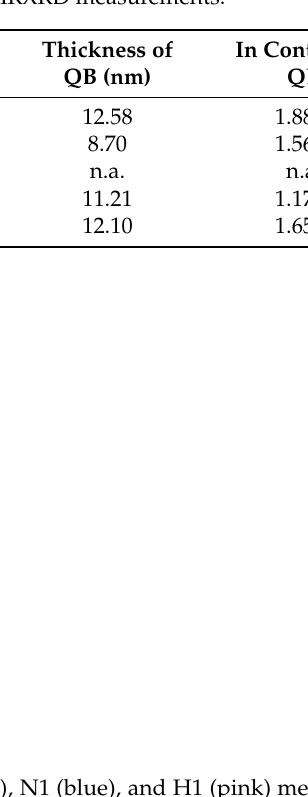
Figure 1. High-resolution X-ray diffraction (HRXRD) ω -2 θ scanning curves on (0002) of sample N1 (annealed in N 2 atmosphere, blue curve) and sample H1 (annealed in H 2 atmosphere, pink curve). The sharpest peaks at ~34.5 ◦ come from GaN diffraction. The arrows indicate the position of satellite peaks. Table 2. Structural parameters of samples determined by HRXRD measurements.